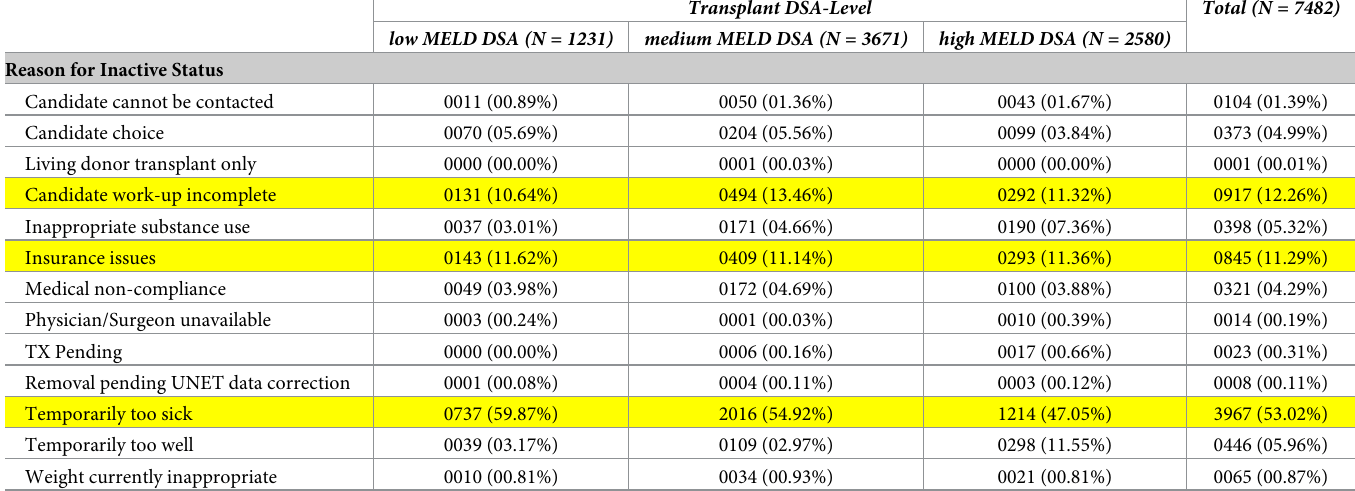
(n = 40). The lowest tertile included MMaT scores from 9–25 (28.4% of patients), the middle tertile ranged from 26–31 (40.7%), and those in the highest tertile MMaT ranged from 32–39 (30.9%). Low and medium MMaT transplant programs had wide geographic distribution; however, as with DSA-level stratification, we noted a markedly disproportionate representa- tion (40.0%) of high MMaT transplant centers in the Western U.S. Similar demographic distri- butions were noted in the transplant center-level data, although there was greater similarity in blood type and gender across MMaT groups and the higher percentage of Hispanics in the high MMaT group remained. The most common reasons for the first inactive status change in both the DSA and transplant center-level data included patients becoming too ill for transplan- tation (53.0%), incomplete candidate workup (12.3%), and issues with insurance coverage (11.3%) (See Tables 1 and 2 for complete set of inactive status change reasons).